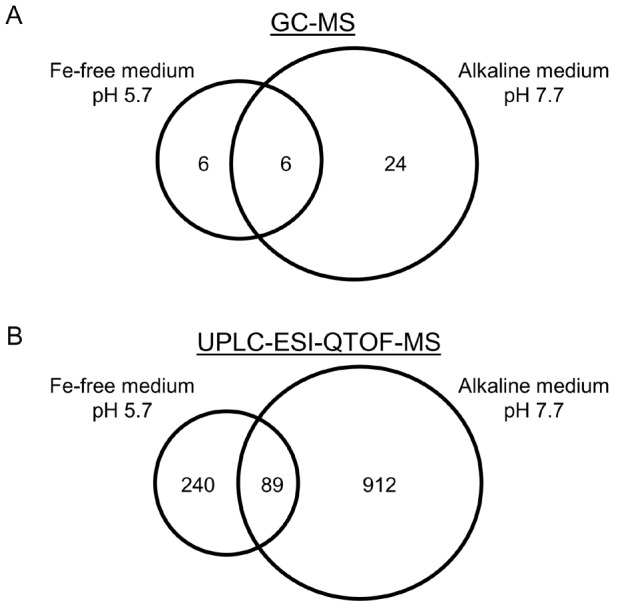
The root metabolome changes triggered by two different conditions of Fe deficiency partially overlap.Venn diagrams display the total number of significant metabolic changes detected by GC-MS (A) and UPLC-ESI-QTOF-MS (B) when comparing growth in the presence of Fe with growth in Fe-free medium for two weeks, or growth at pH 5.7 with growth at pH 7.7. Detailed analysis focused on the metabolites and features (m/z – retention time pairs) that were shared by the two conditions of Fe deficiency (see Tables 1 and 2, Tables S1 and S2 in File S6).